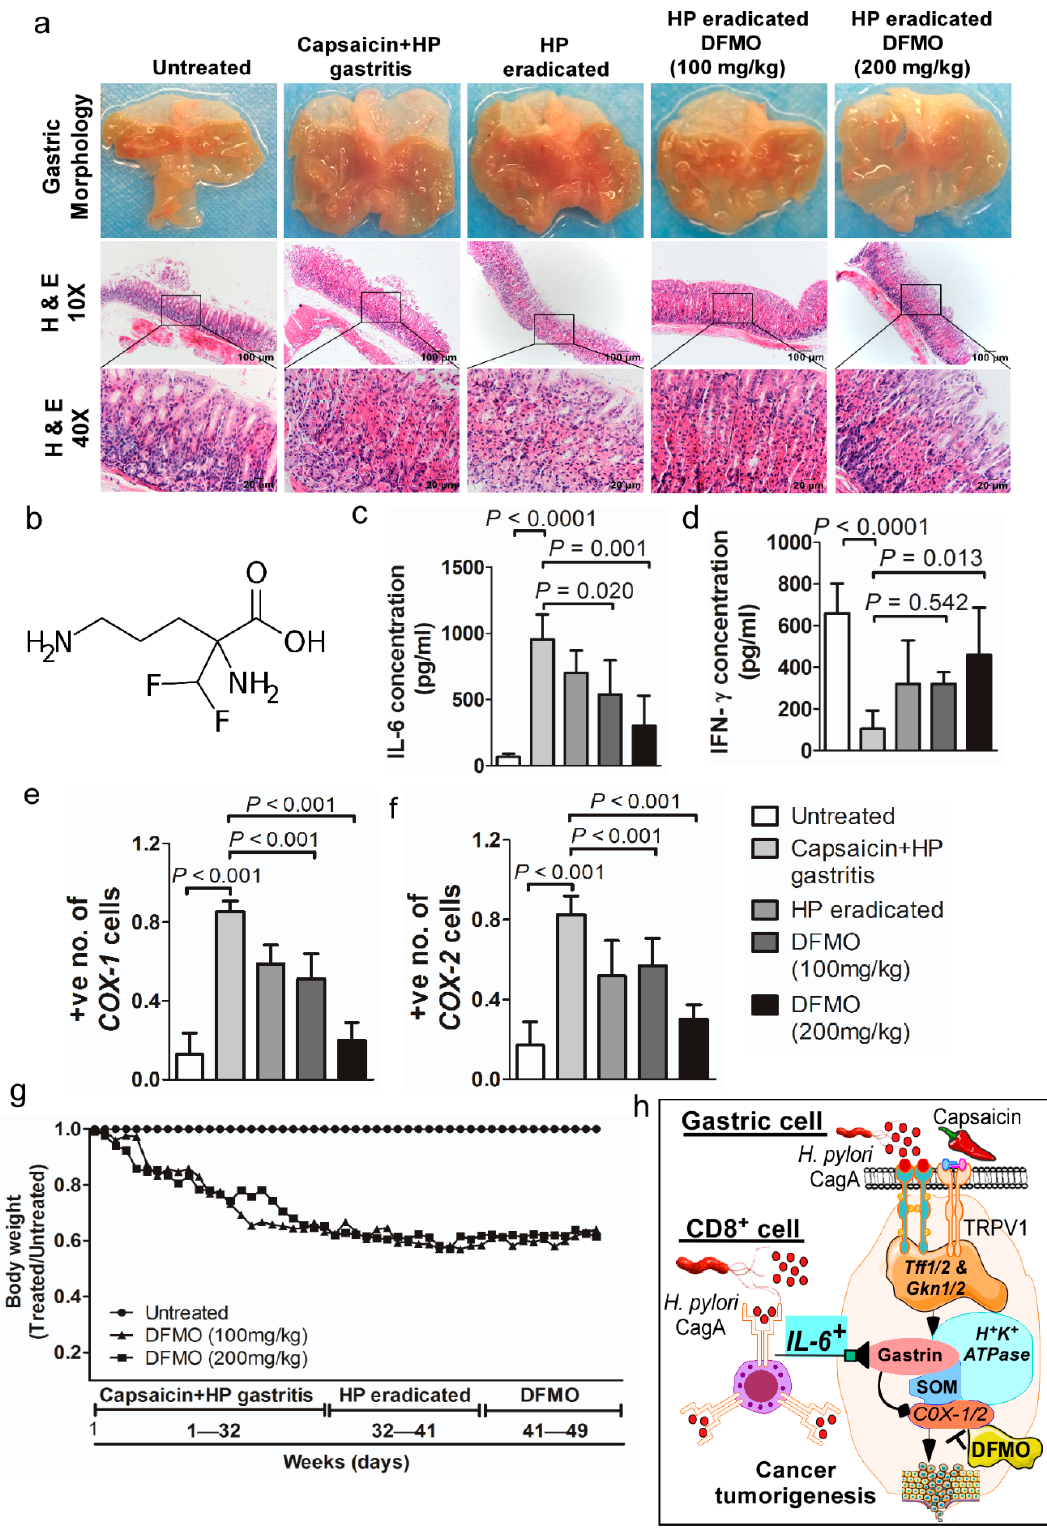
Figure 6. 2-difluoromethylornithine (DFMO) preventive gastritis mouse model. ( a ) The gastric tissues from mice exhibiting gastritis induced by capsaicin and H. pylori or mice with H. pylori that was eradicated and treated with DFMO (100 or 200 mg/kg) did not show tumor development ( n = 5/cohort). Histological sections were stained with H&E. The scale bars represent 100 μ m (×10) and the